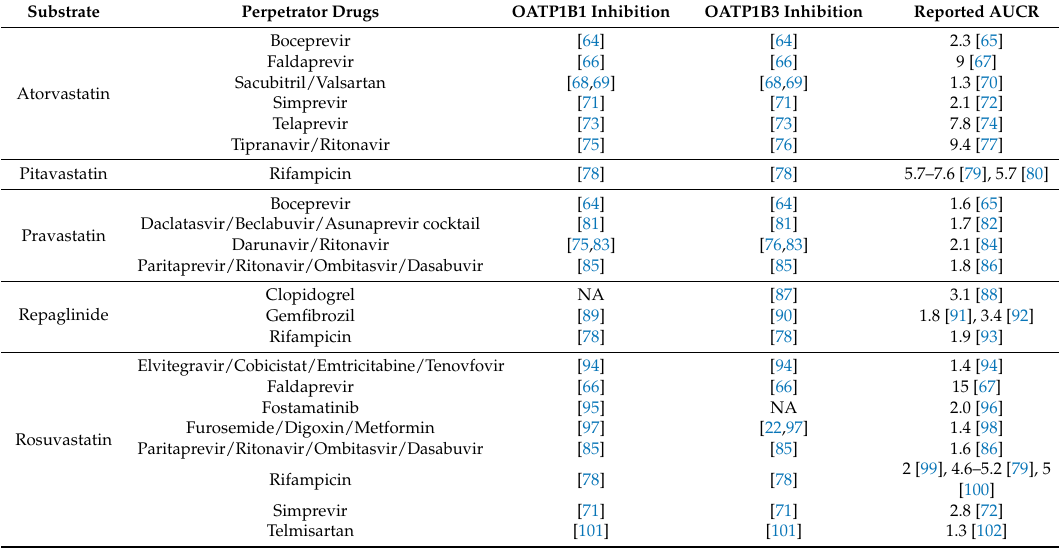
Table 1. Summary of observed AUC ratio (AUCR) of clinical substrates of